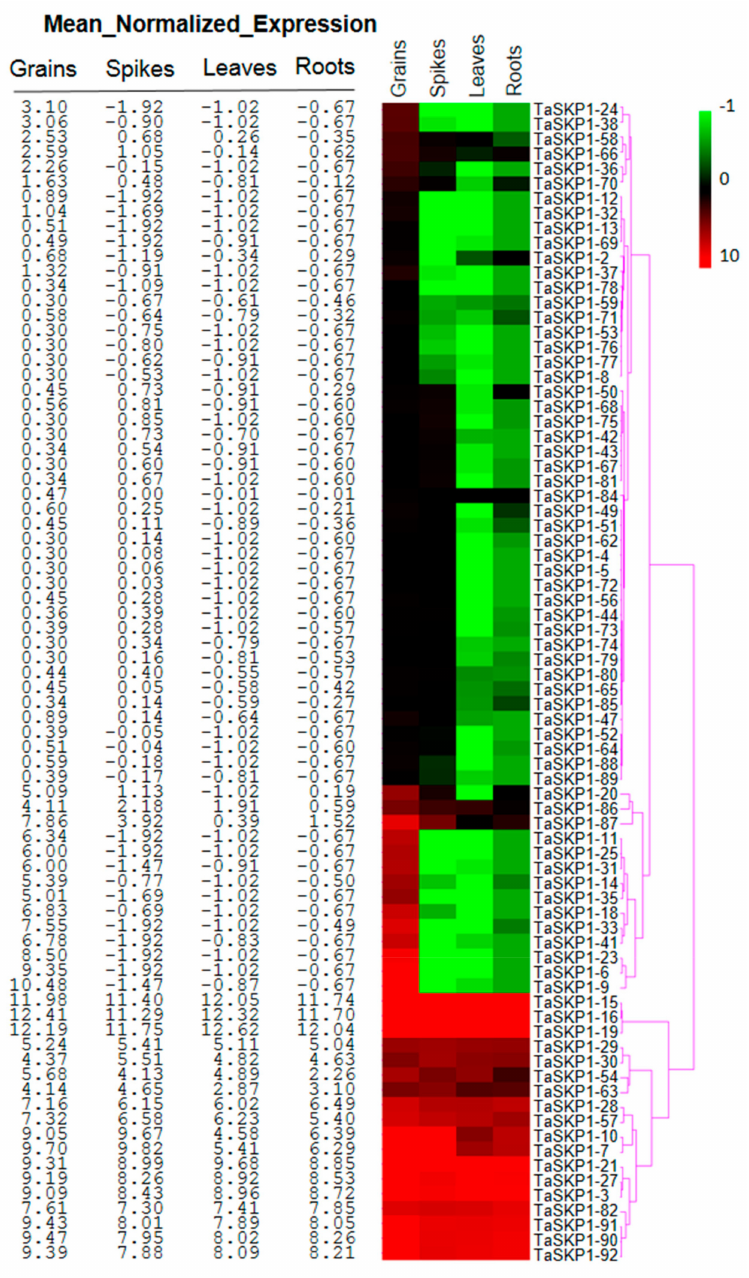
Figure 5. Heat map of the 92 TaSKP1-like genes’ expression profiles in wheat grains, spikes, leaves and roots. Hierarchical clustering was performed for the transcript abundance from all tissues. The values indicate the expression level of each gene normalized using the TMM and Voom methods [30,31] after removing non-expressed genes. Highly expressed genes are highlighted in red, weakly expressed genes are highlighted in